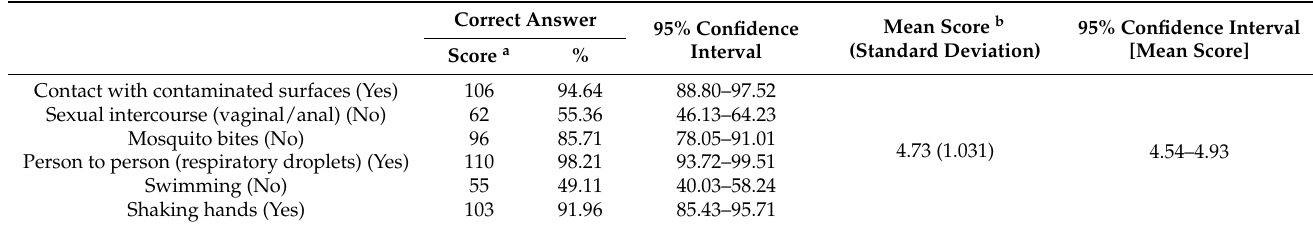
Table 2. Knowledge about the modes of transmission of COVID-19.